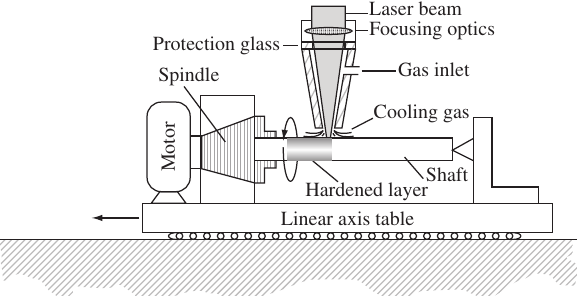
Figure 1. Experimental setup schematics for the shaft laser surface harden-